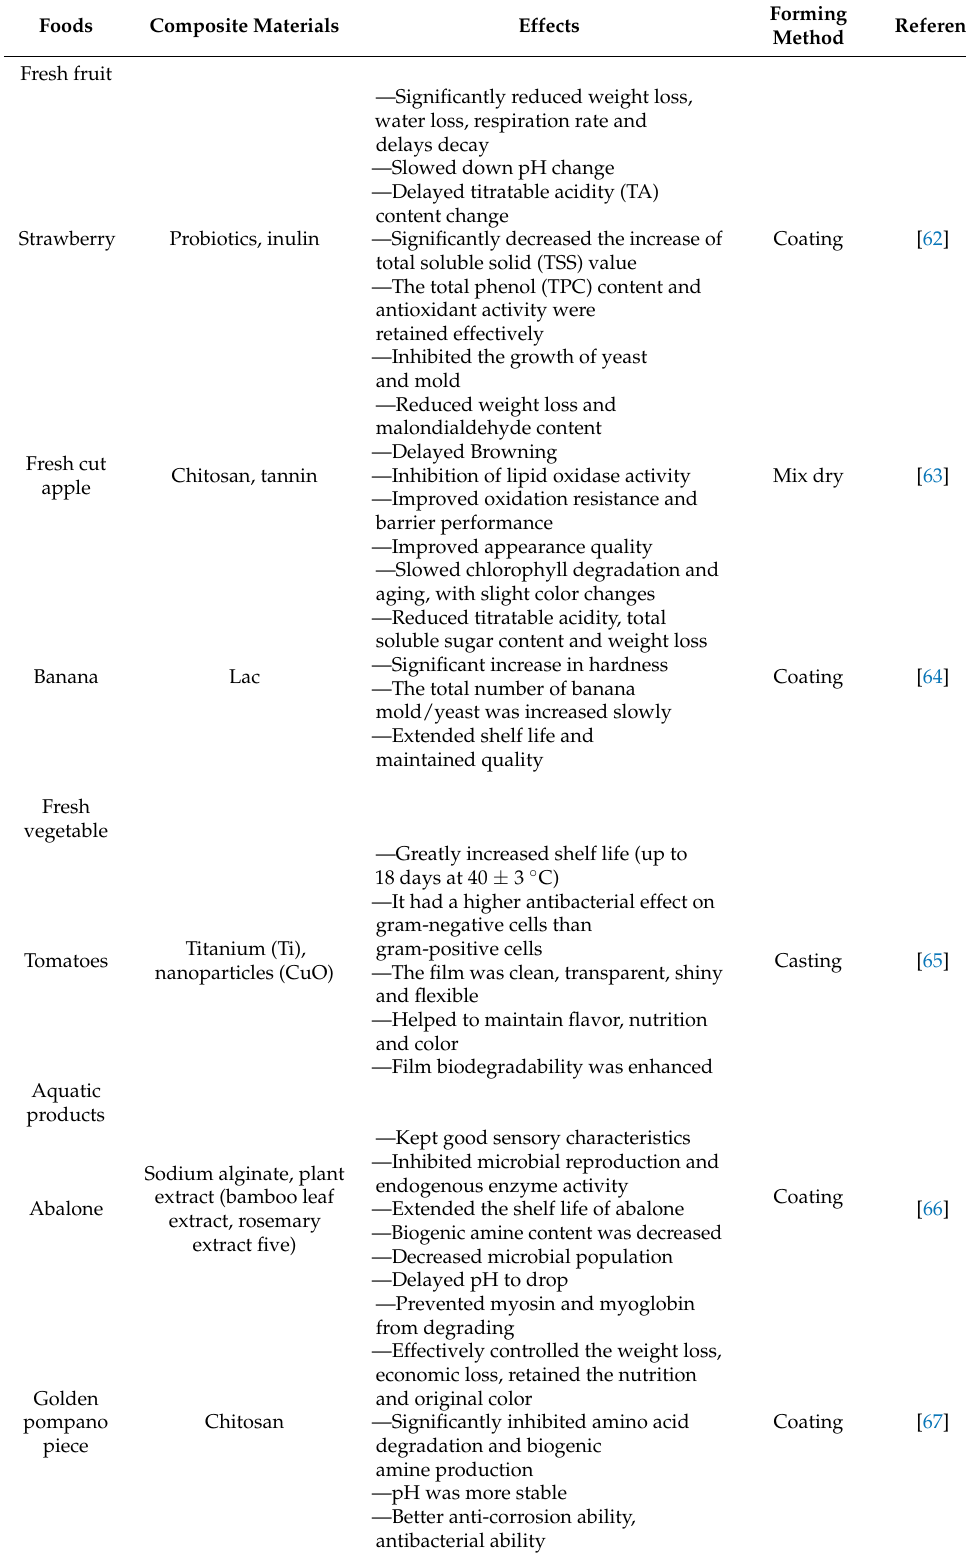
Table 2. Findings and forming method of gelatin-based composite films and coatings on food